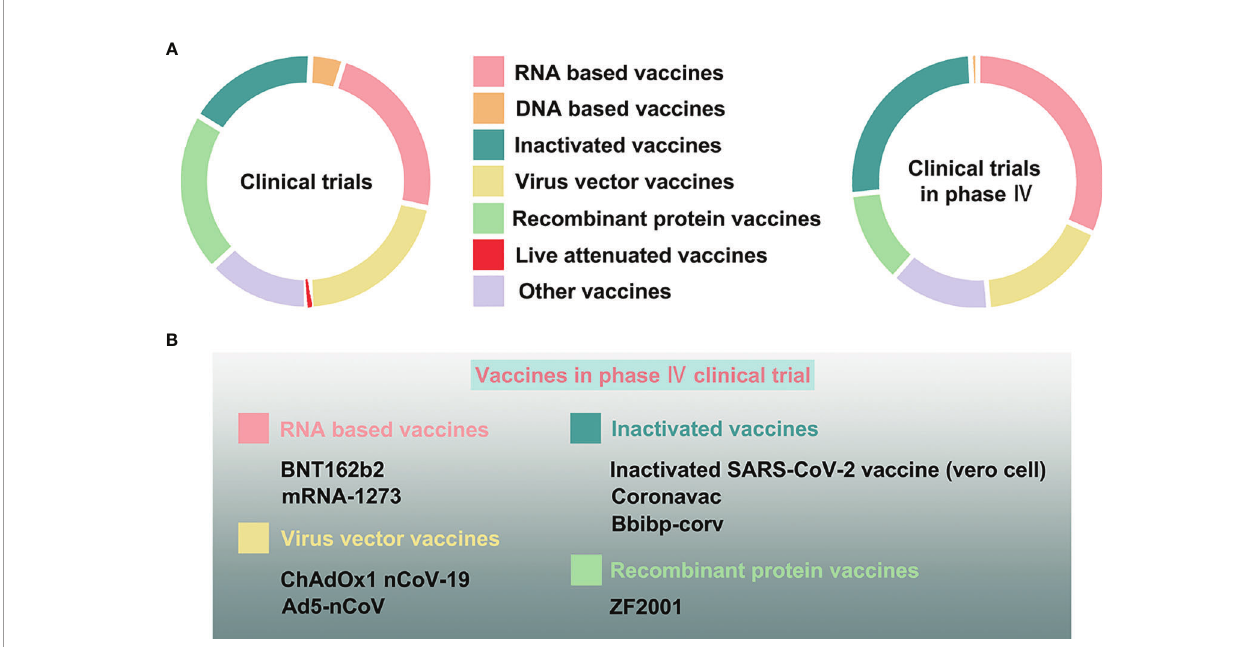
FIGURE 6 | The clinical trialsassessing COVID-19 vaccines. (A) The proportion of varying vaccine types, namely, RNA-based, DNA-based,inactivated, live attenuated, virusvector,recombinant protein, andother vaccines, in allclinicaltrials, andespecially in phase IVclinical trials. (B) The COVID-19 vaccines inphase IV